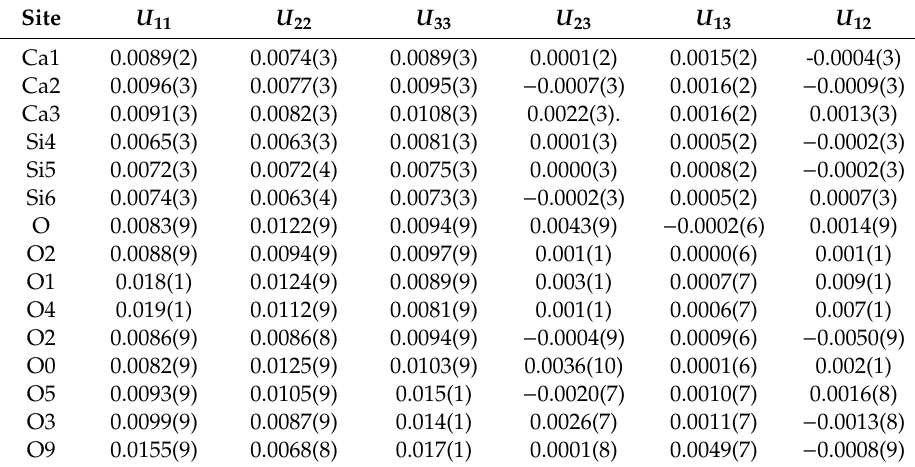
Table 9. Anisotropic temperature factors (Å 2 ) in wollastonite (CE 5B).